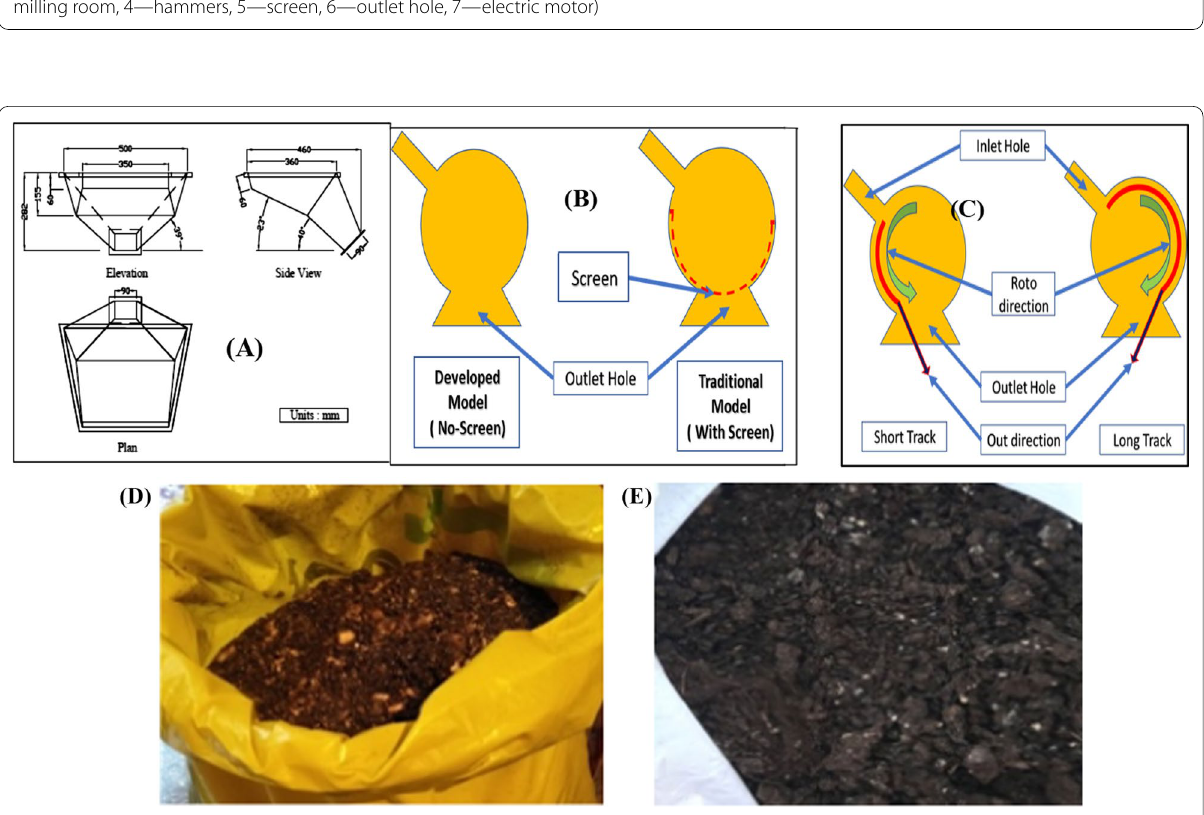
Fig. 3 Hopper of mushroom residues: A Hopper of mushroom residues; B type of outlet hole before and after development; C track direction of chopping; D MR after chopping; and E MR after chopping followed by